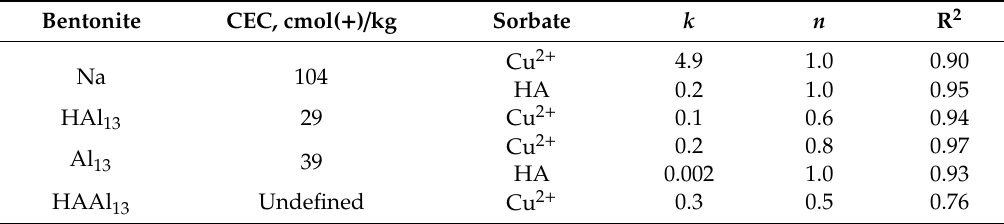
Table 1. CEC and the parameters of the Freundlich equation for di ff erent forms of